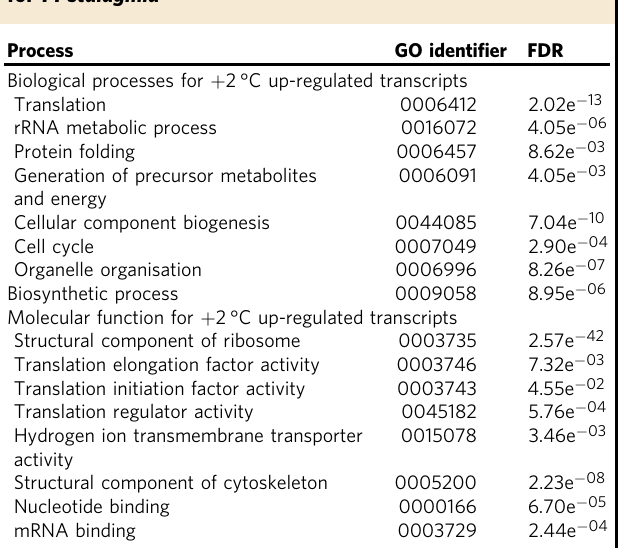
Table 1 PANTHER v13.1 GO-slim overrepresentation tests for P. stalagmia